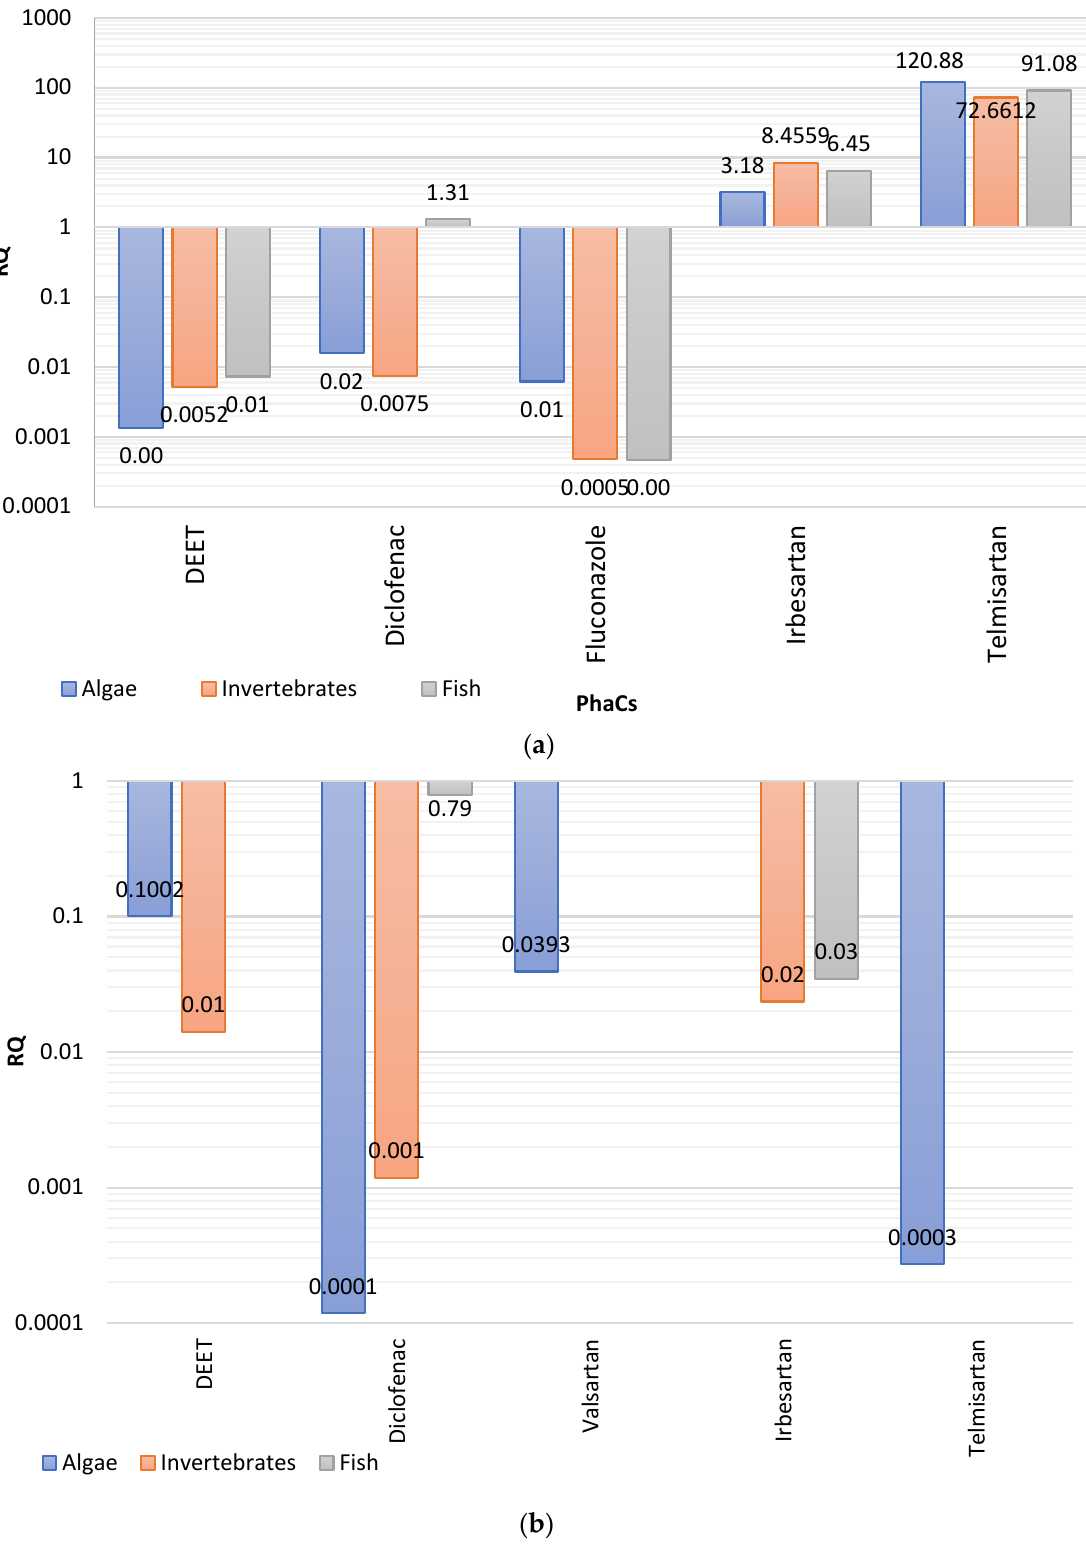
Figure 3. Risk quotients (RQ) calculated for the ( a ) acute, and ( b ) chronic toxicity deriving from the most concentrated compounds detected in effluents .